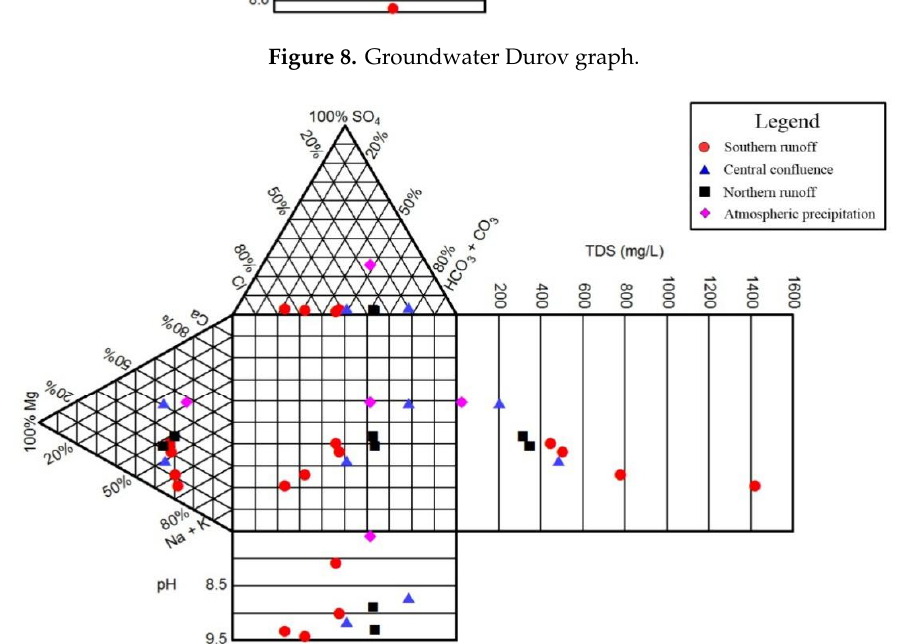
Figure 8. Groundwater Durov graph.